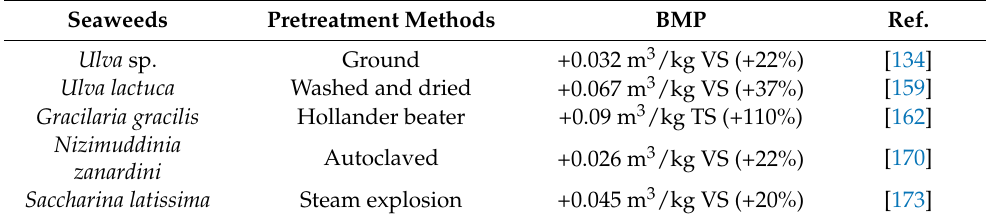
Table 3. Improvement of BMP of seaweeds through the employed pretreatment methods.